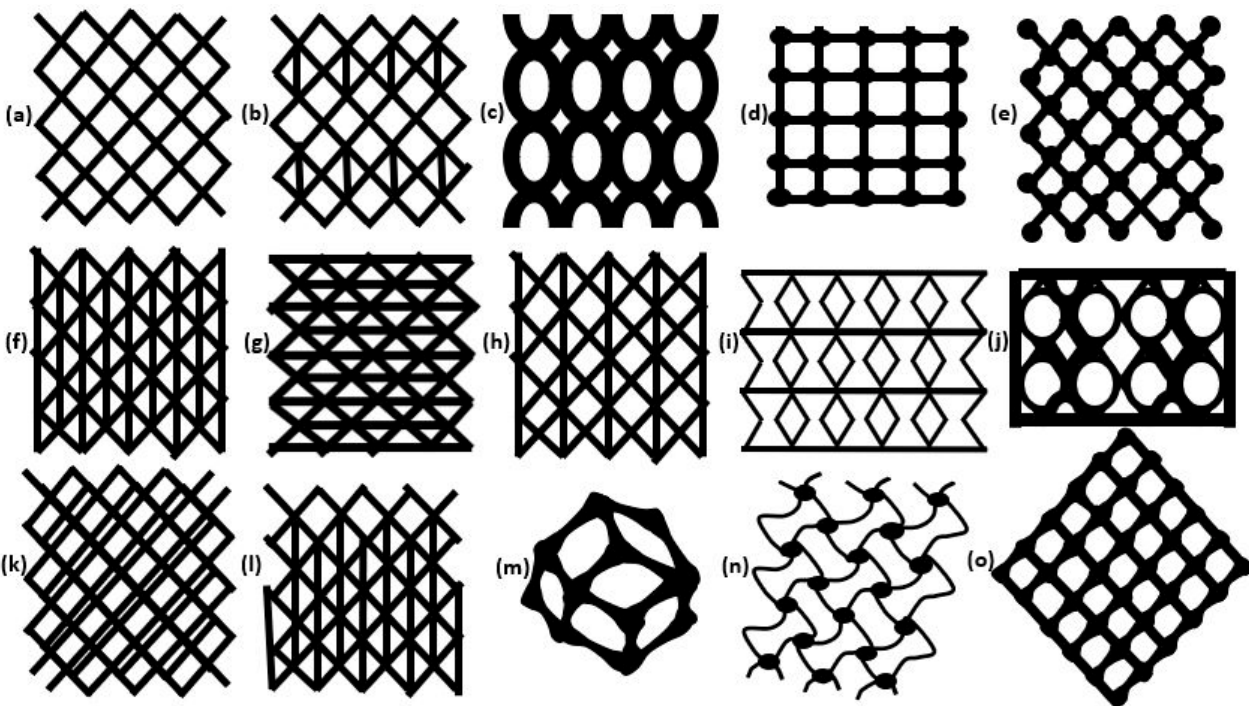
Figure 4. Schematic representation of Lattices proposed and commonly studied and reported in the literature: ( a ) BCC [7,16,23,24,33–35,37,44,50,55,56,58–61,64,66–69]. ( b ) BCCA with vertical struts in alternating layers [64]. ( c ) ARCH lattice with arch strut arched at the centre line [38]. ( d ) TOP cubic lattice [42]. ( e ) TPMS Based BCC [16]. ( f ) BCCZ or BCCV with vertical struts [23,34,35,63,64]. ( g ) BCCZ-H with horizontal struts [35]. ( h ) FCCZ with vertical struts [23]. ( i ) Auxetic lattices assembly without crosslink [65]. ( j ) Sea urchin (SU) lattice structure [7,56]. ( k ) F2BCC a combination of two BCC cells [34]. ( l ) BCCG with an increasing number of vertical struts from none at the top to all at the bottom [64]. ( m ) Rhombic dodecahedron (RD) lattice with modified struts [39]. ( n ) Gyroid lattice [10,13,15,20,45,54]. ( o ) GBCC with increased radii corner of the BCC nodes [37].